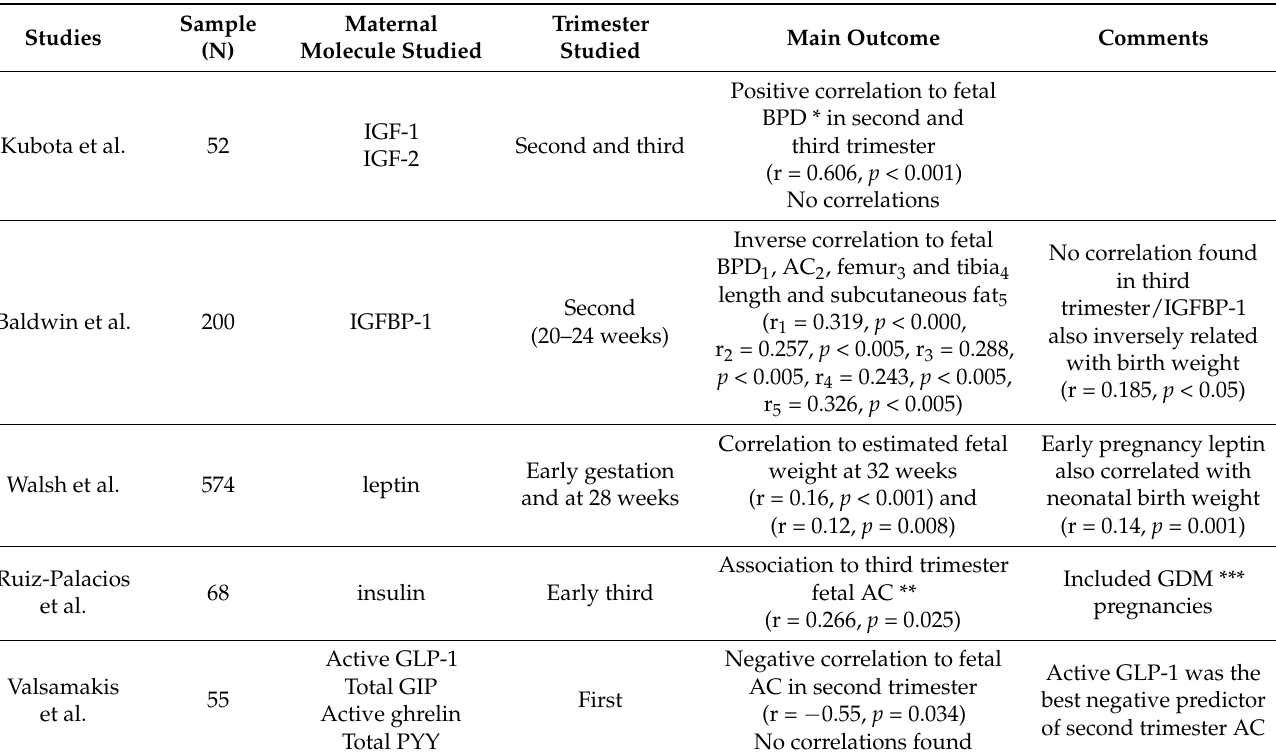
Table 1. Studies of maternal molecules implicated in appetite regulation in relation to intra-uterine fetal growth indices. * BPD: biparietal diameter, ** AC: abdominal circumference, *** GDM: gestational diabetes